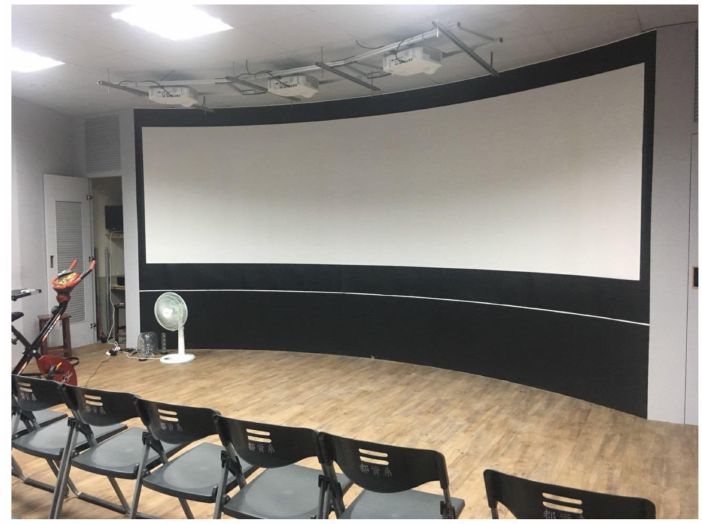
Figure 17. iSpace-Urban Simulation and Cloud Computing Laboratory of Feng Chia University.